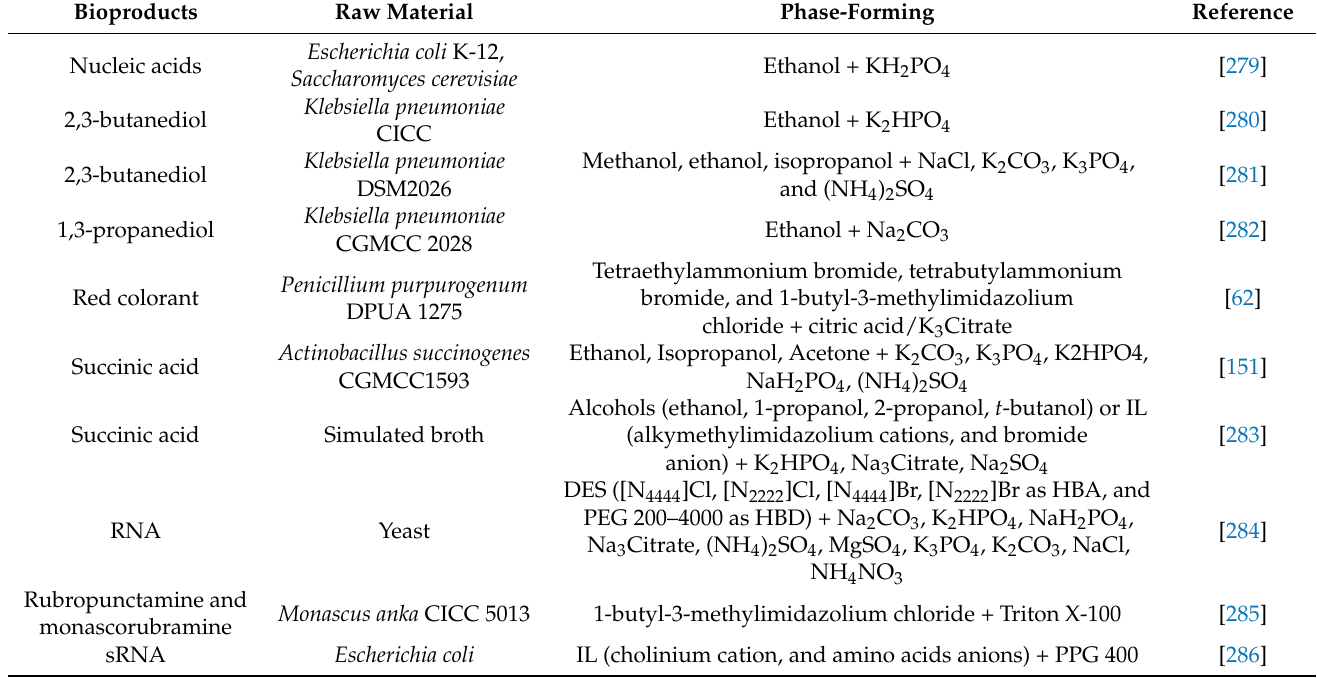
Table 5. Nonconventional ATPS in the extraction and recovery of microbial